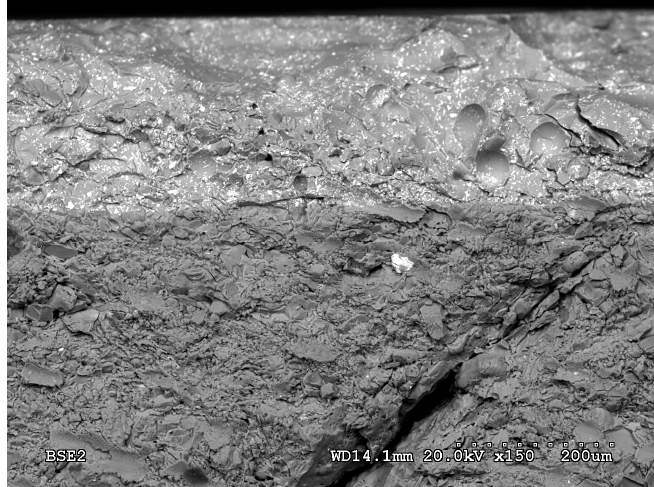
Figure 8. SEM microscope applying 150 magnifications of a tile section. Porcelain stoneware and glazed substrate.